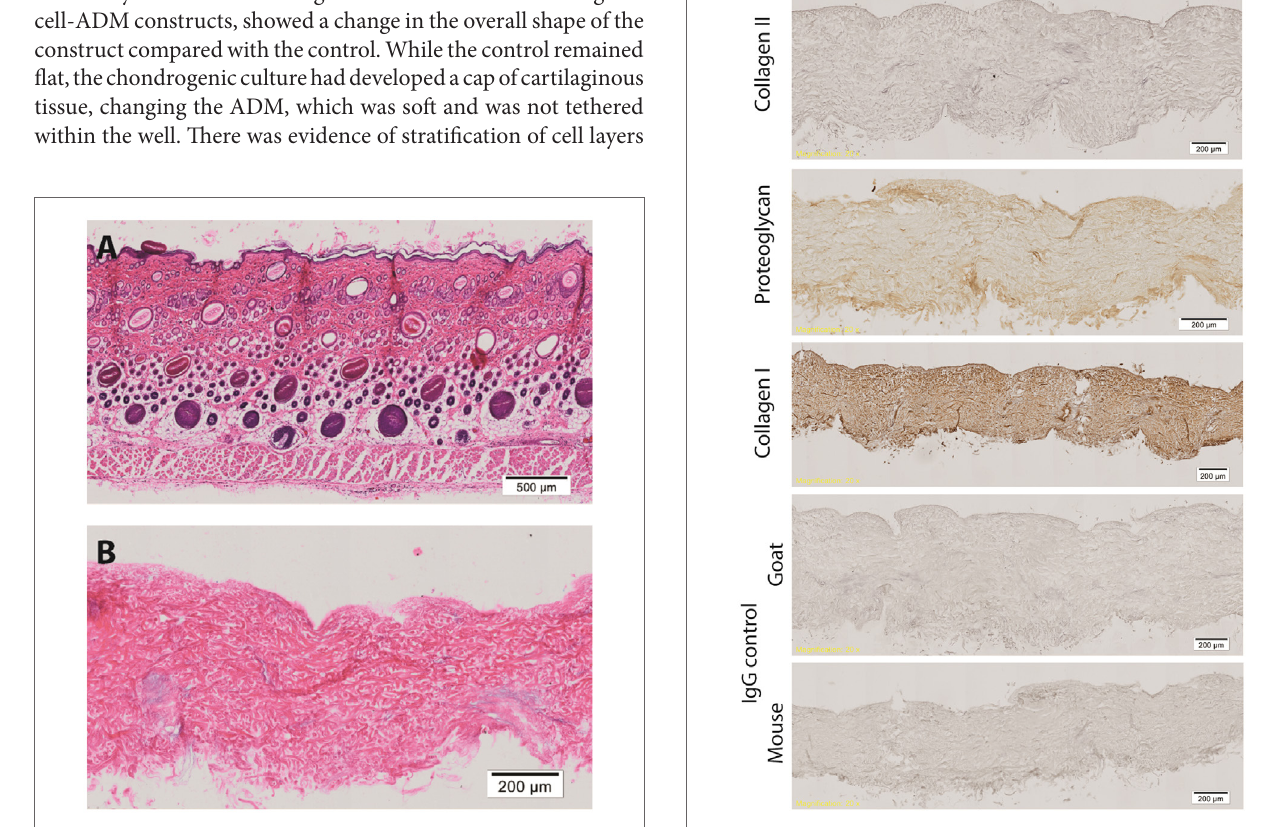
FigUre 2 | immunohistochemistry of processed rat skin. Representative figures of immunohistochemistry of rat ADM shows intact bundles of collagen Type I fibers throughout the matrix. Some minor proteoglycan staining is evident throughout the ADM. There is no staining for collagen Type II. All isotype controls (IgG mouse and goat) were negative. Scale bars as indicated. Magnification: 10 × .